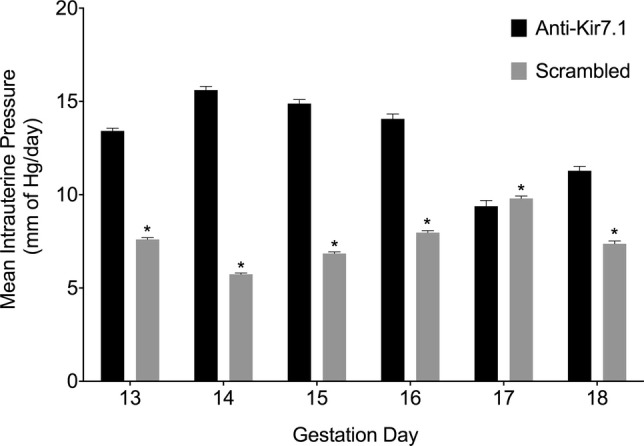
Knockdown of Kir7.1 in vivo significantly increases intrauterine pressureMice in which Kir7.1 was knocked down (Anti-Kir7.1) had significantly increased intrauterine pressure when compared to mice injected with scrambled miRNA lentivirus (scrambled) from GD13 to GD18 (Fig 6 and Supplementary Fig S3). (n = 6 per time point). *P < 0.05; see methods for statistical model.